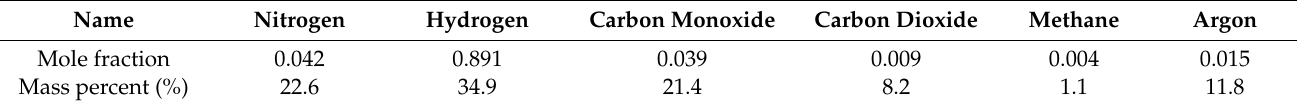
Table 1. Composition of the recycled gas for the studied hydrogen compressor.